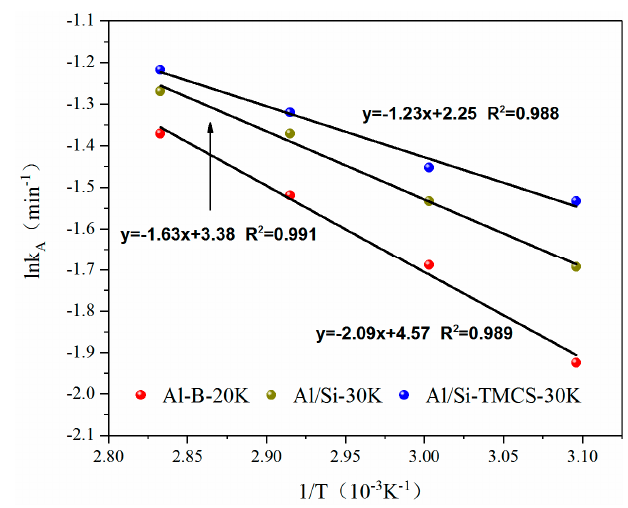
Figure 10. Arrhenius plot of k A obtained by Avrami’s fractional order.